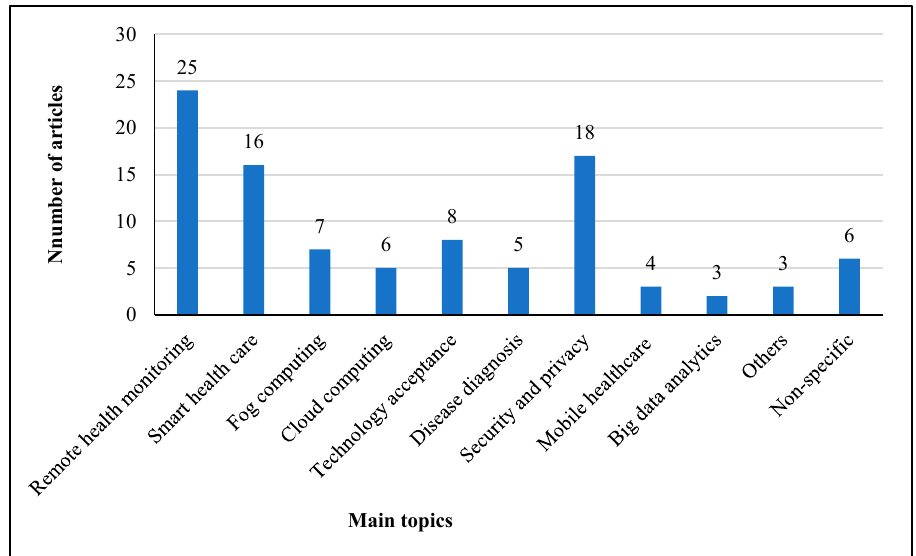
Figure 8. Distribution based on research purpose/objectives.